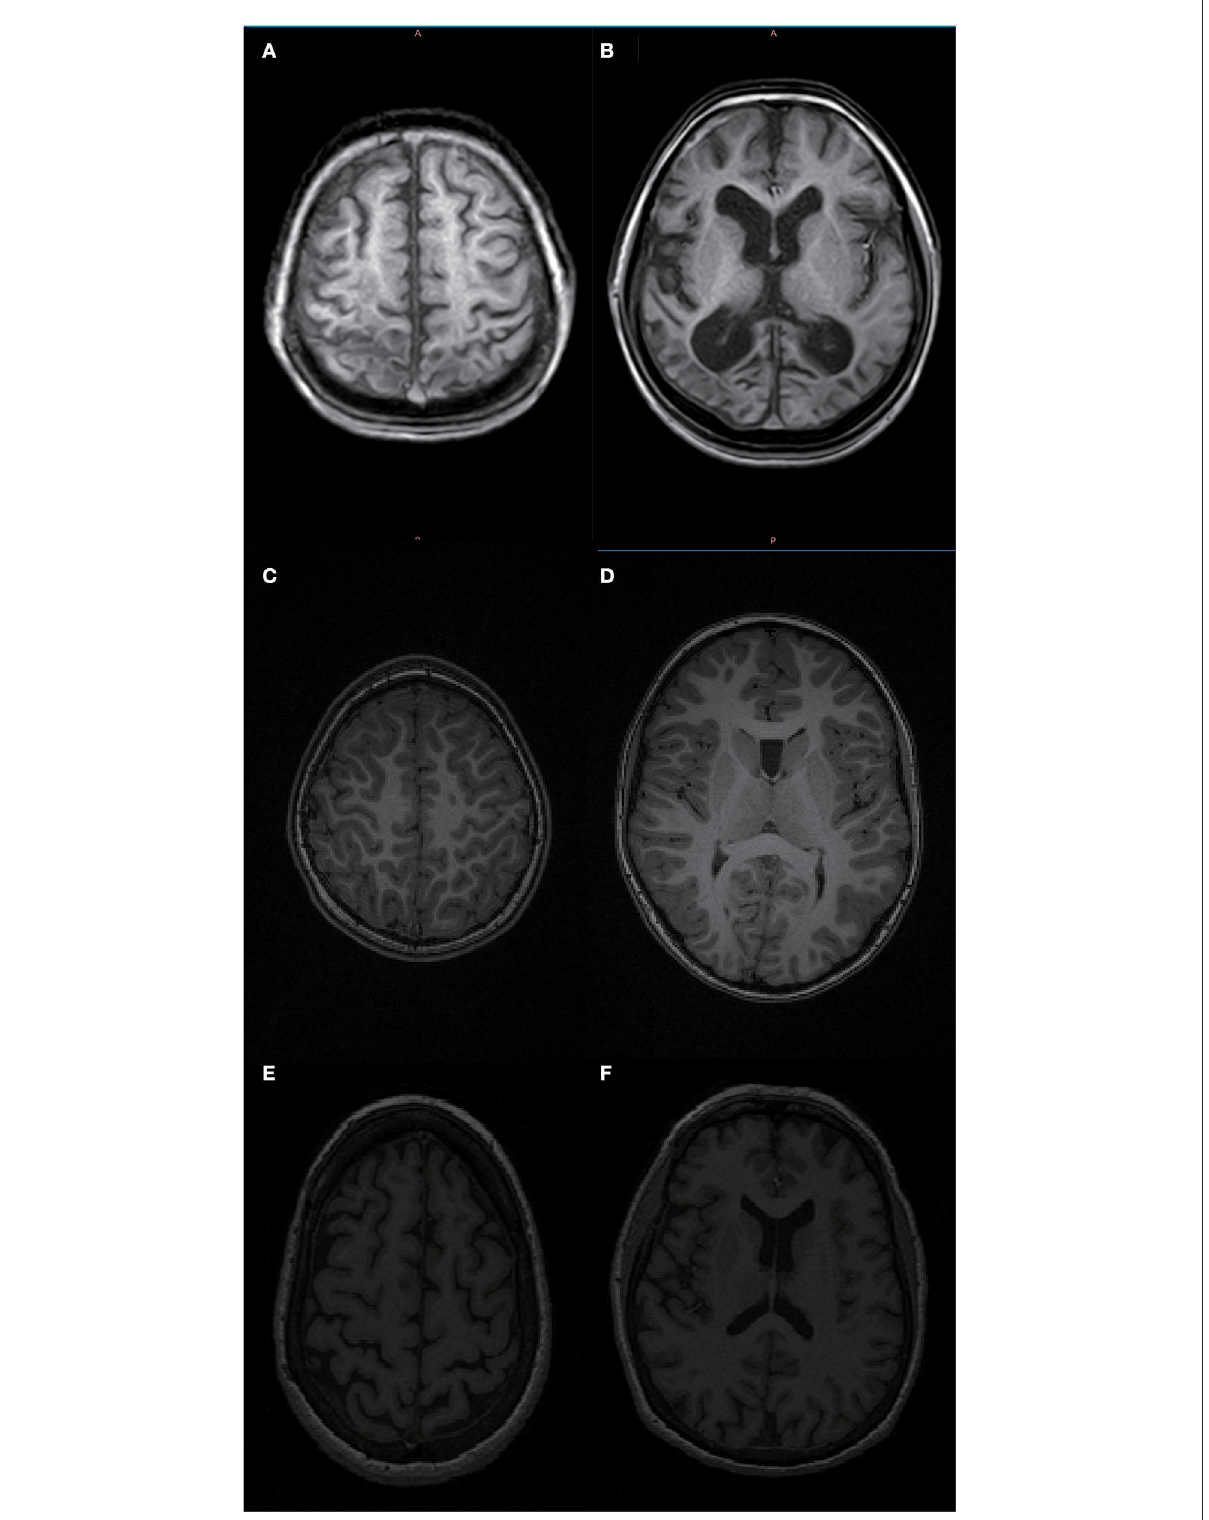
FIGURE5 MRI of an 11-year-old patient with bilateral spastic cerebral palsy vs. an 11- and 62-year-old healthy person. As shown in (A,B) the head MRI of an 11-year-old patient with bilateral spastic cerebral palsy, who has significant brain atrophy and the patient’s brain age is 61.74 years; (C,D) the head MRI of an 11-year-old healthy person; (E,F) the head MRI of a 62-year-old healthy elderly person. Based on the pictures, we can see that the 11-year-old bilateral spastic cerebral palsy patient’s degree of brain atrophy is relatively close to that of a 62-year-old healthy elderly